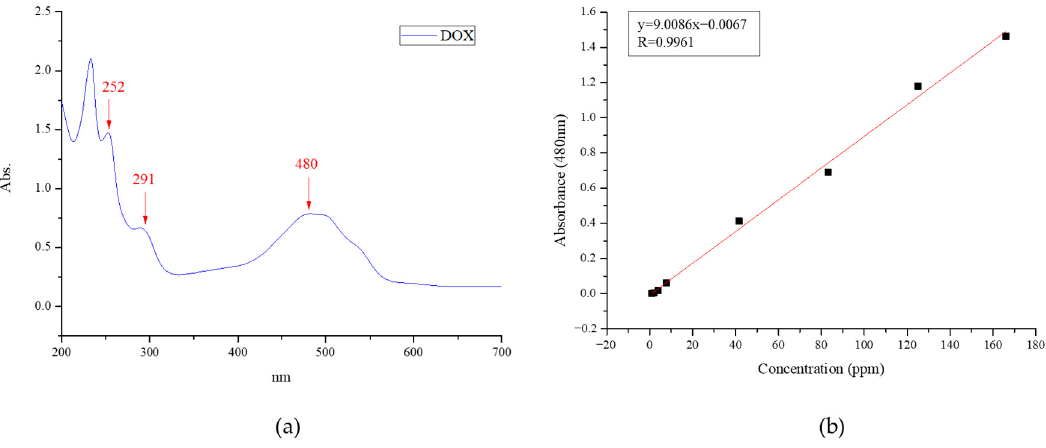
Figure 4. ( a ) UV–VIS spectrum of the DOX solution. ( b ) Calibration curve of absorbance at 480 nm versus the DOX concentration (ppm) in DI water.